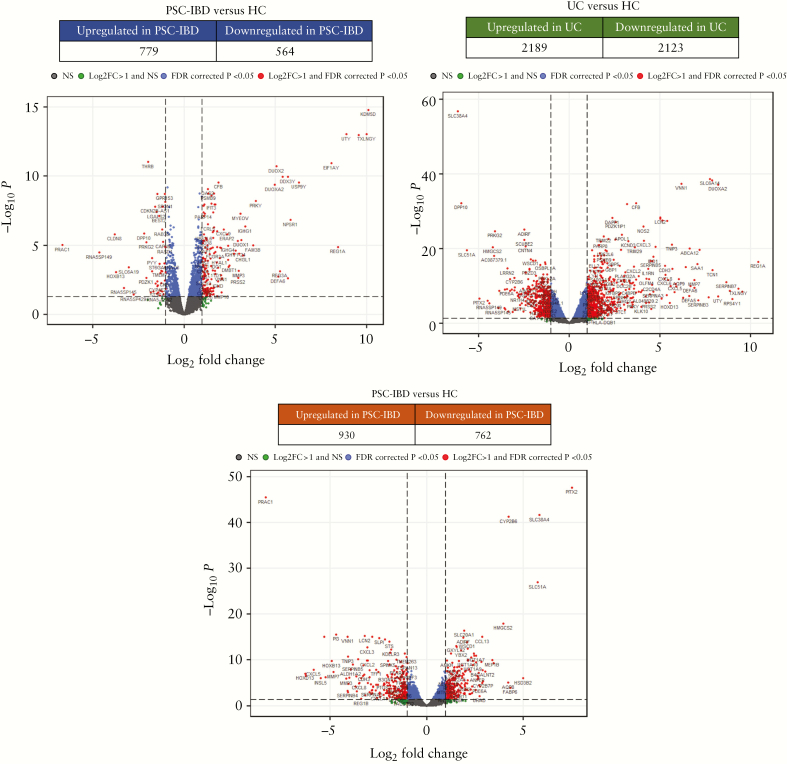
Differential gene expression profiles and volcano plots highlighting differentially expressed genes. [a] PSC-IBD versus HC; [b] UC versus HC; [c] PSC-IBD versus UC. Differentially expressed genes with logFC >1 are shown; 939 genes had shared differential expression in PSC-IBD and UC when compared with healthy controls [588 upregulated; 351 downregulated]. PSC, primary sclerosing cholangitis; IBD, inflammatory bowel disease; UC, ulcerative colitis; HC, healthy controls.